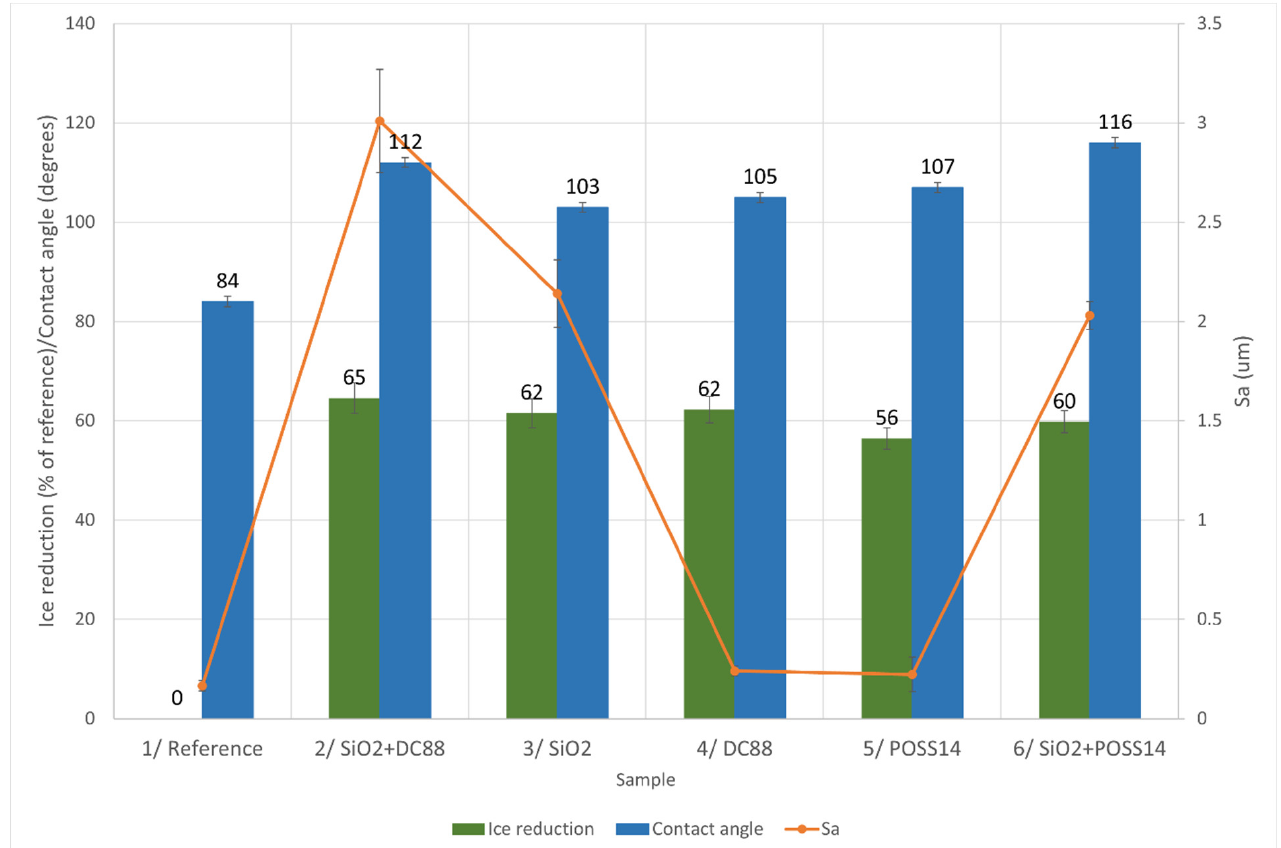
Figure 6. Comparison of different characteristics in aspect of glaze ice reduction.